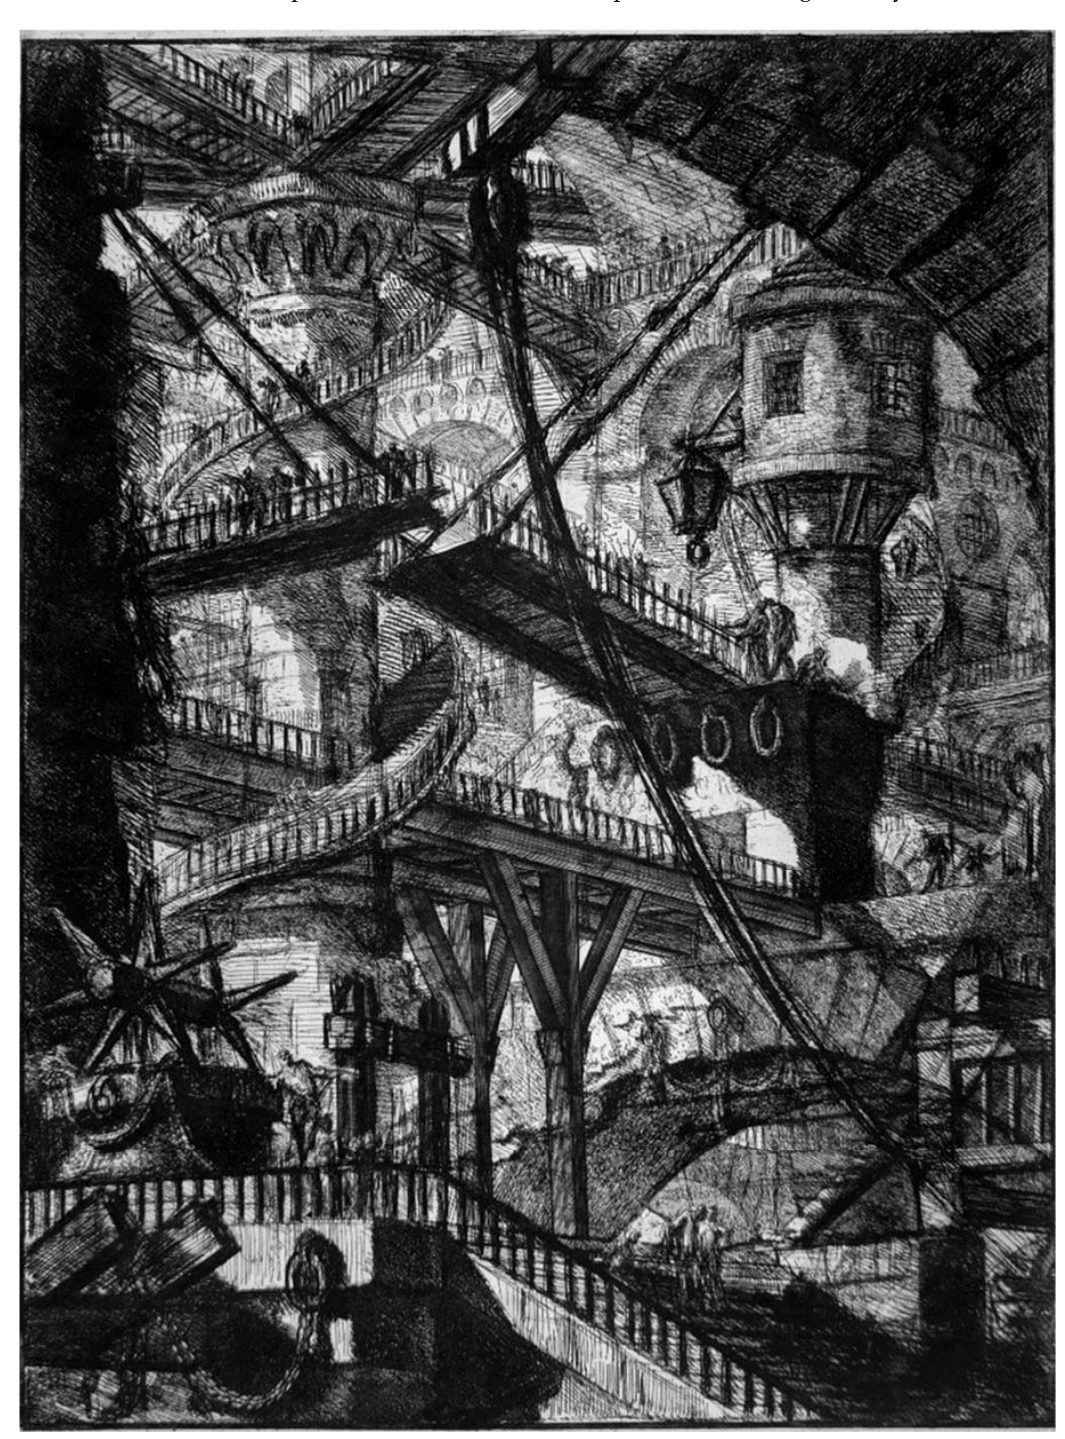
high value compared to a mid-range fractal with D = 1.3 to 1.4 is a result of fine lines filling in the space more than seems to be optimal for our cognitive system.